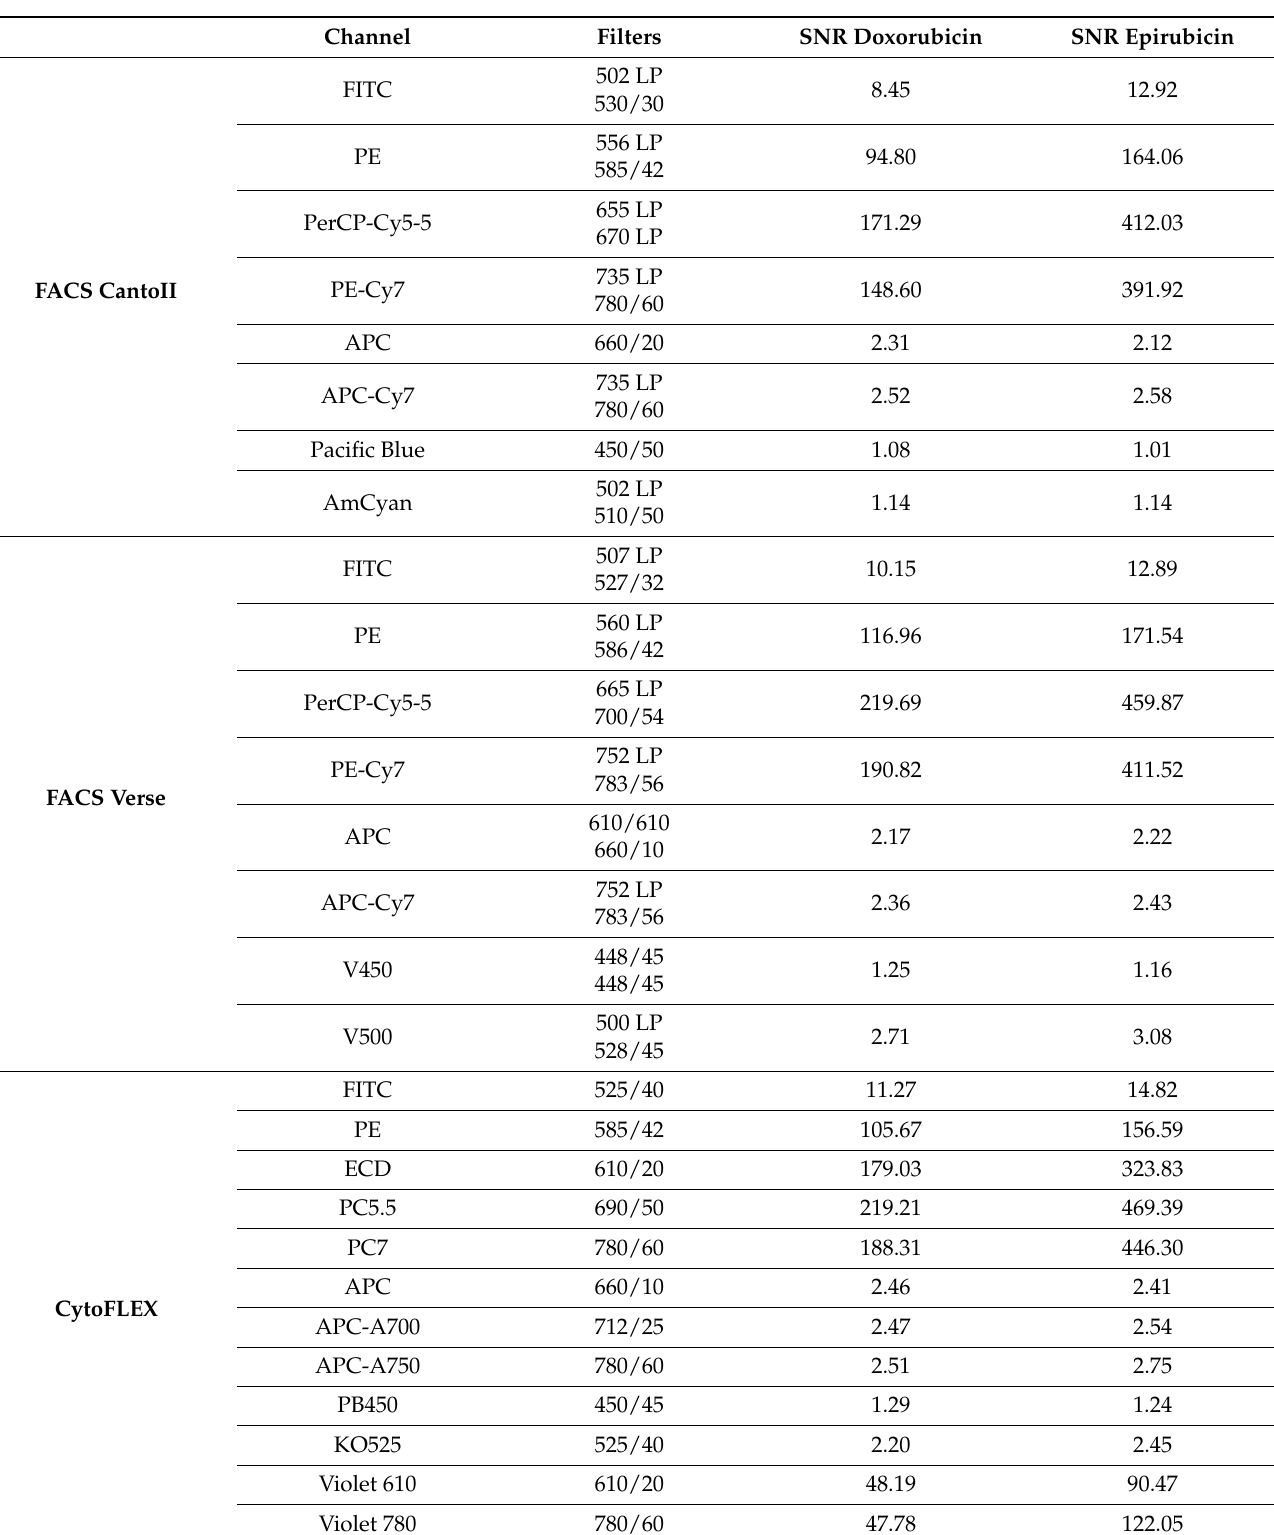
Table 1. Signal-to-noise ratio (SNR)